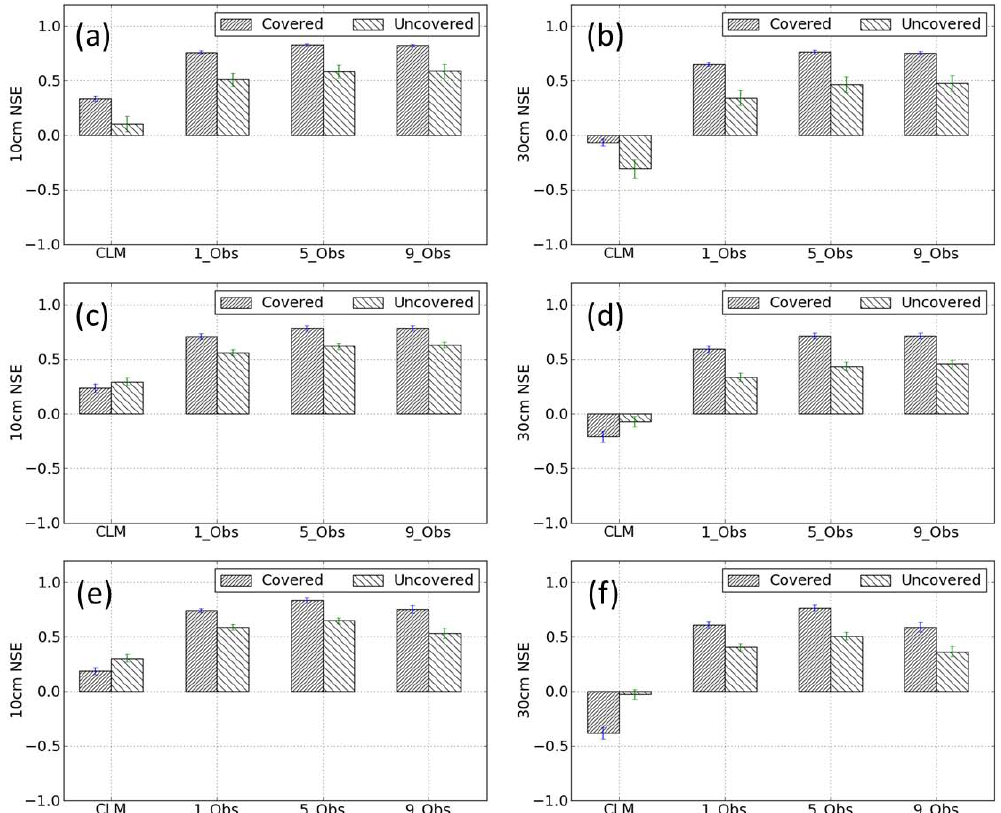
Fig. 5. Mean NSE values of soil moisture (including 95% confidence intervals) for open loop simulations (CLM) and three assimilation strategies of 1 observation used (1 Obs), 5 observations used (5 Obs) and 9 observations used (9 Obs) for 10cm and 30cm depth. Results are shown for 70% – 10cm (a) , 30cm (b) – 47% – 10cm (c) , 30cm (d) – and 31% – 10cm (e) , 30cm (f) – observational